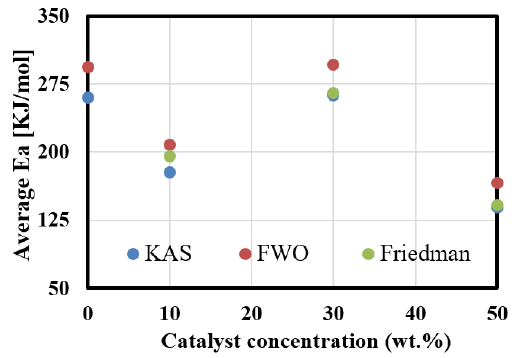
Figure 8. Effect of catalyst concentration on the apparent activation